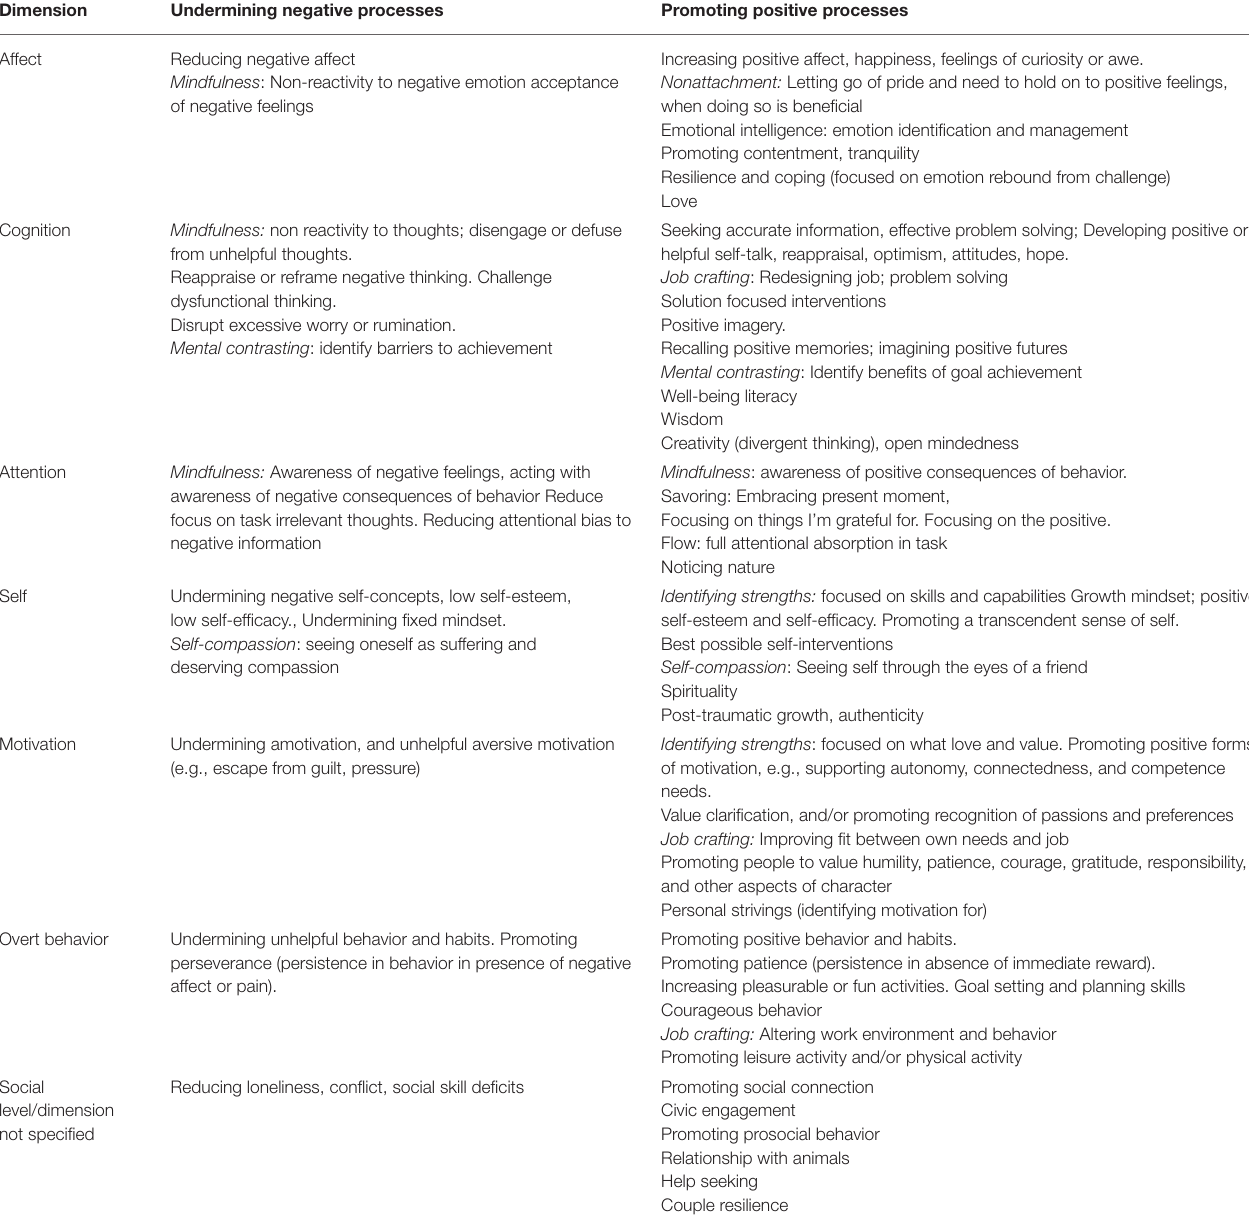
TABLE 1 | Evidence-based processes classified by